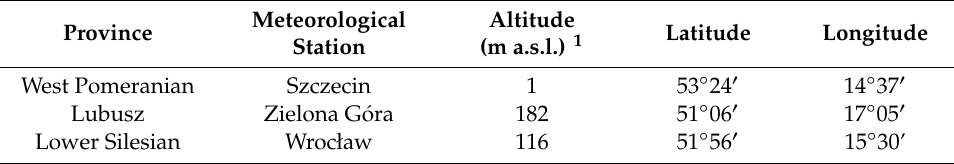
Table 1. Geographical location of considered meteorological stations in western